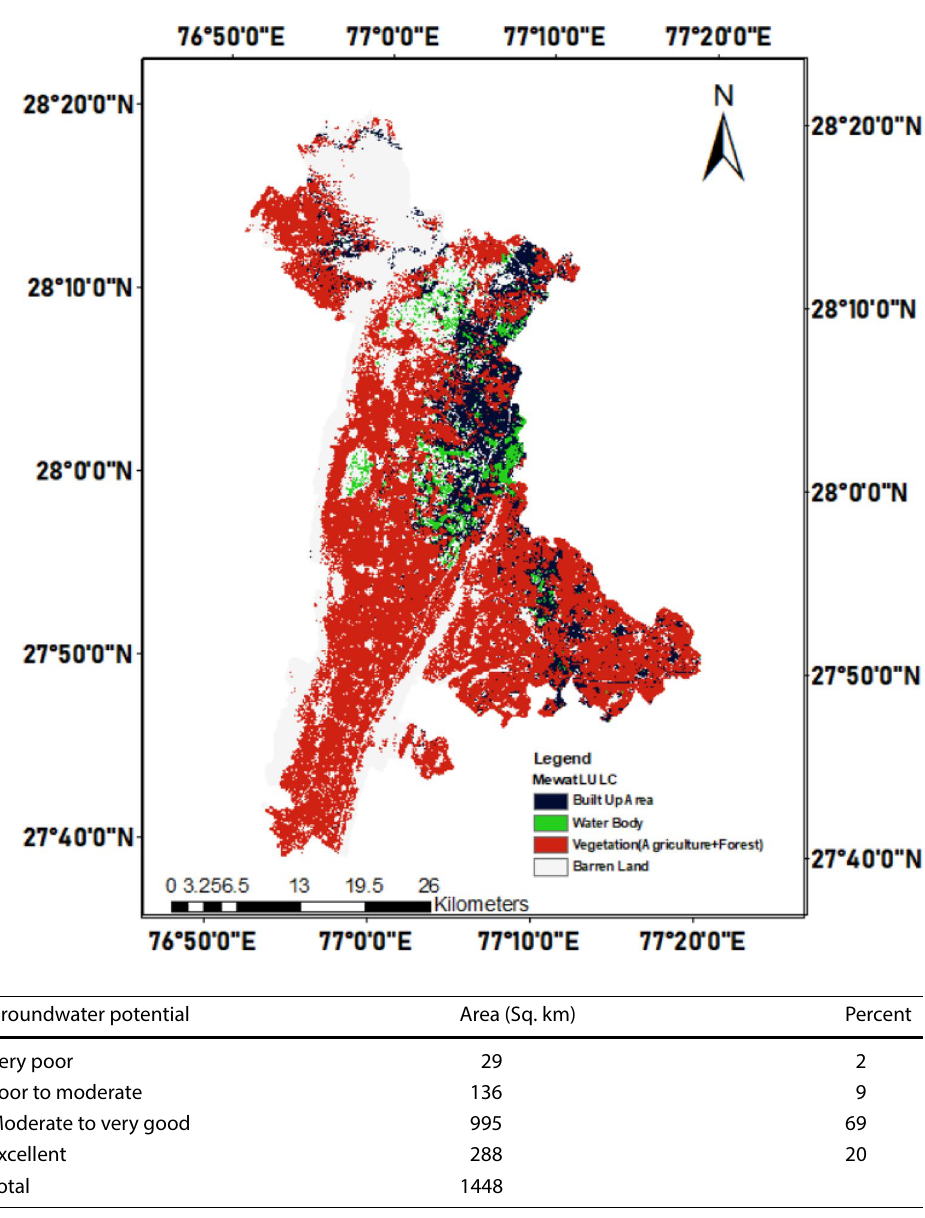
Table 3 Assessment of groundwater potential of Mewat,